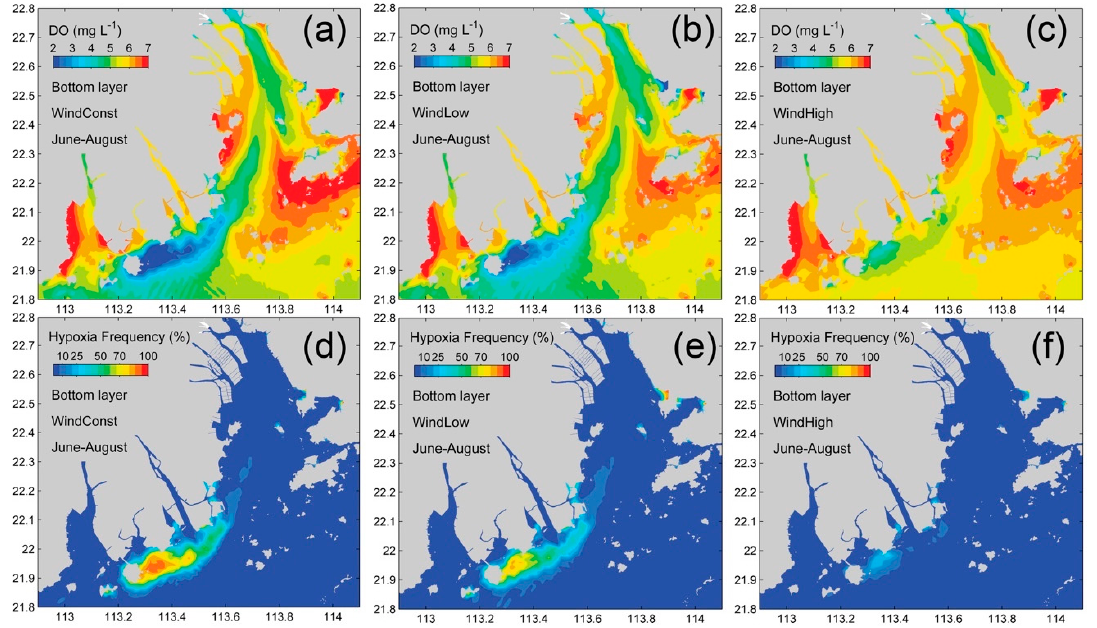
Figure 12. Spatial distribution of the simulated DO concentration and HF in the bottom layer for WindConst ( a , d ), WindLow ( b , e ), and WindHigh ( c , f ) cases.